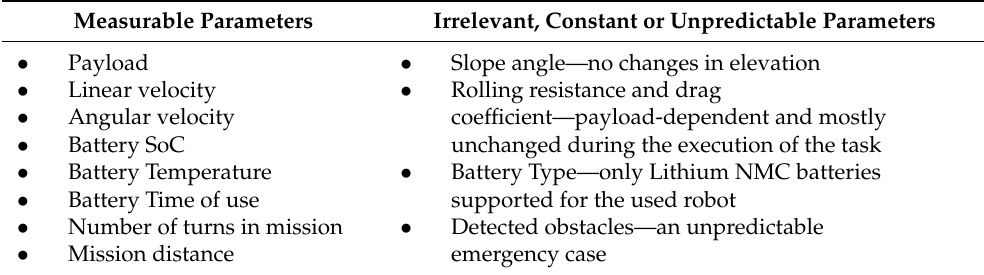
Table 1. Parameters to be considered in the